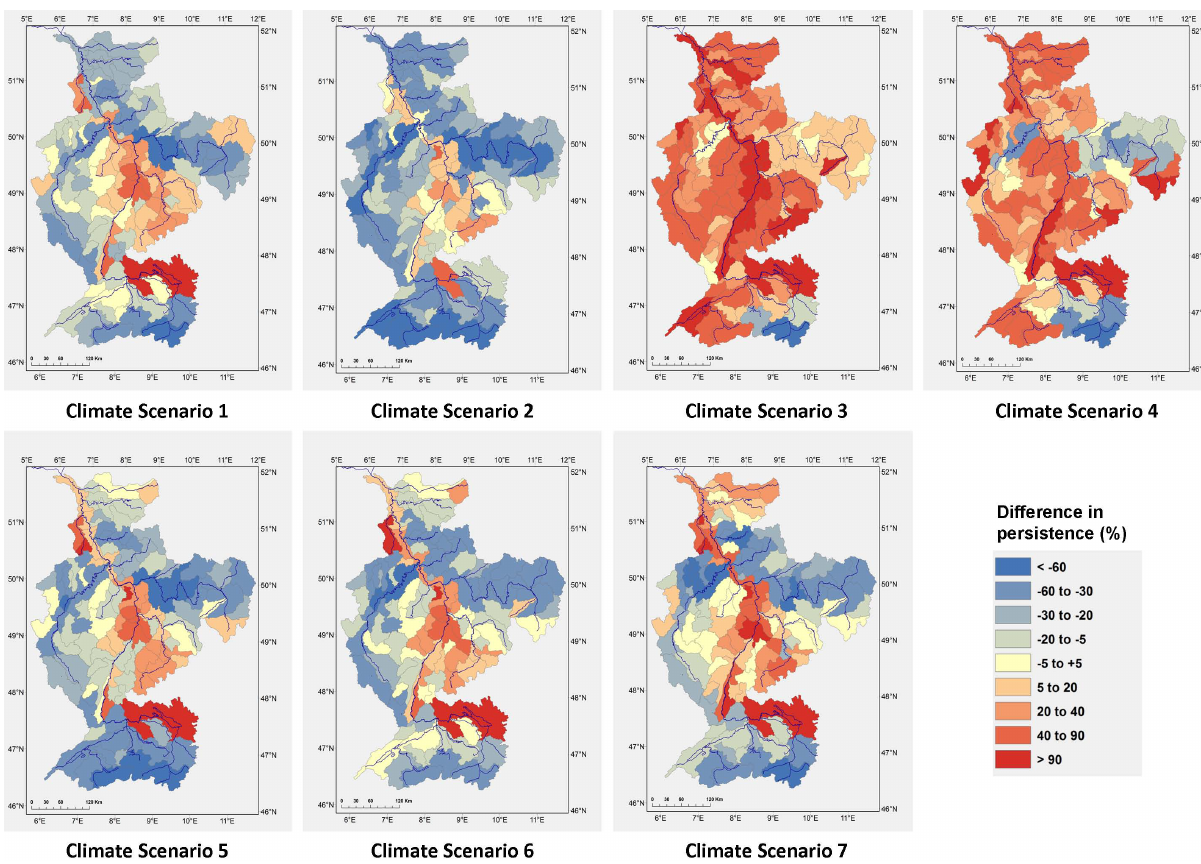
Fig. 4. Relative differences (%)* between low flow persistence estimated from simulated low flows using simulated inputs from seven climate scenarios for the reference period 1964–2007 (case 3) and simulated low flows using observed inputs for the same period (case 2). * (Based on simulated input – Based on observed input)/Based on observed